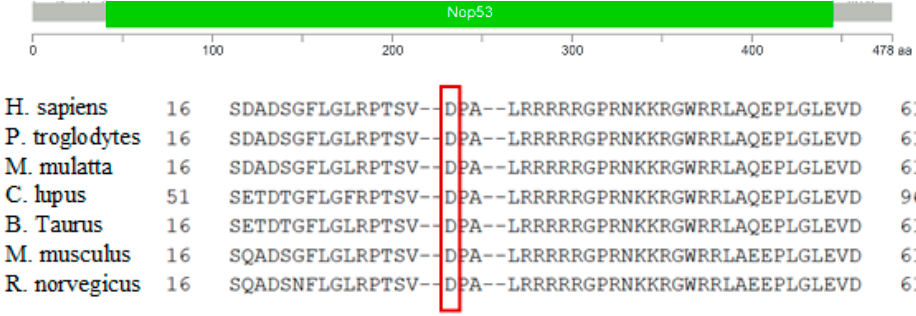
Figure 2. Sequence obtained from Sanger sequencing from one representative wild type and mutant sample.